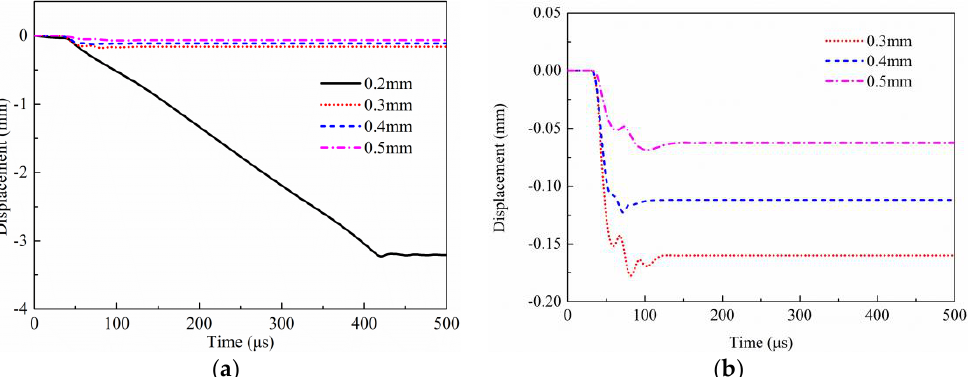
Figure 15. Displacement – time curves of the piston during dropping process: ( a ) Overall curves, ( b ) Local enlarged curves.